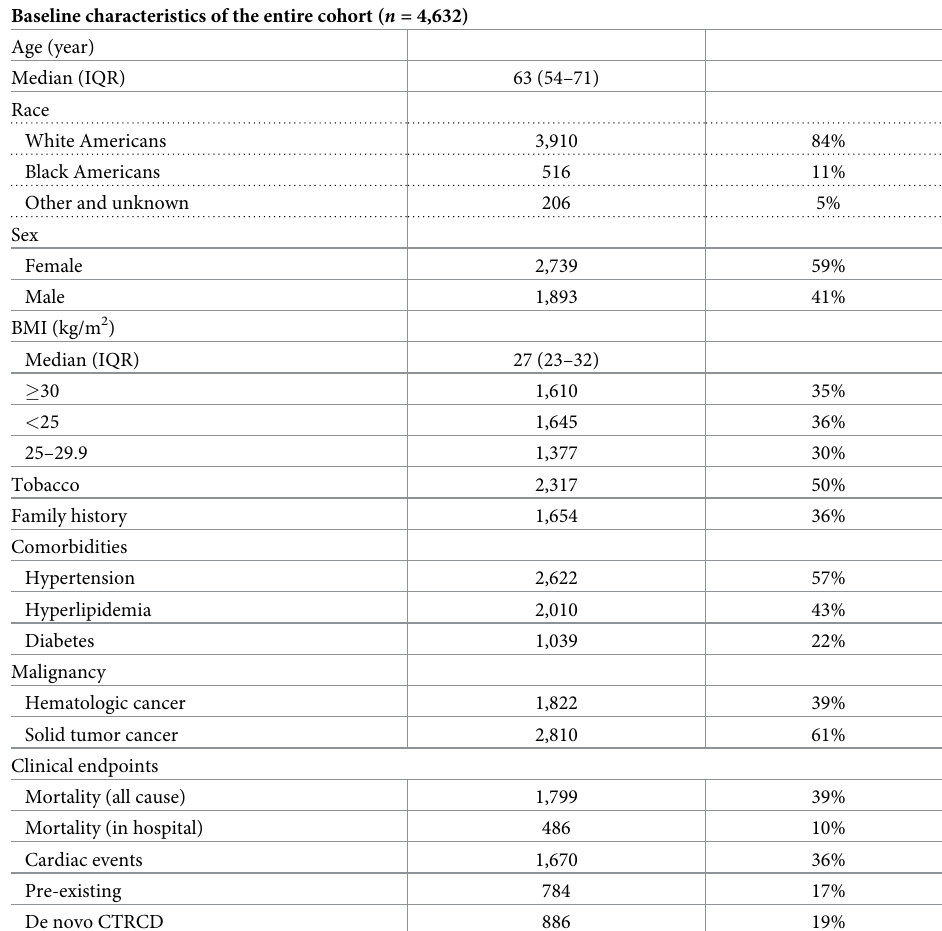
categorical variables were presented as number of percentages, n (%). Cardiac events: 5 hospital diagnosed